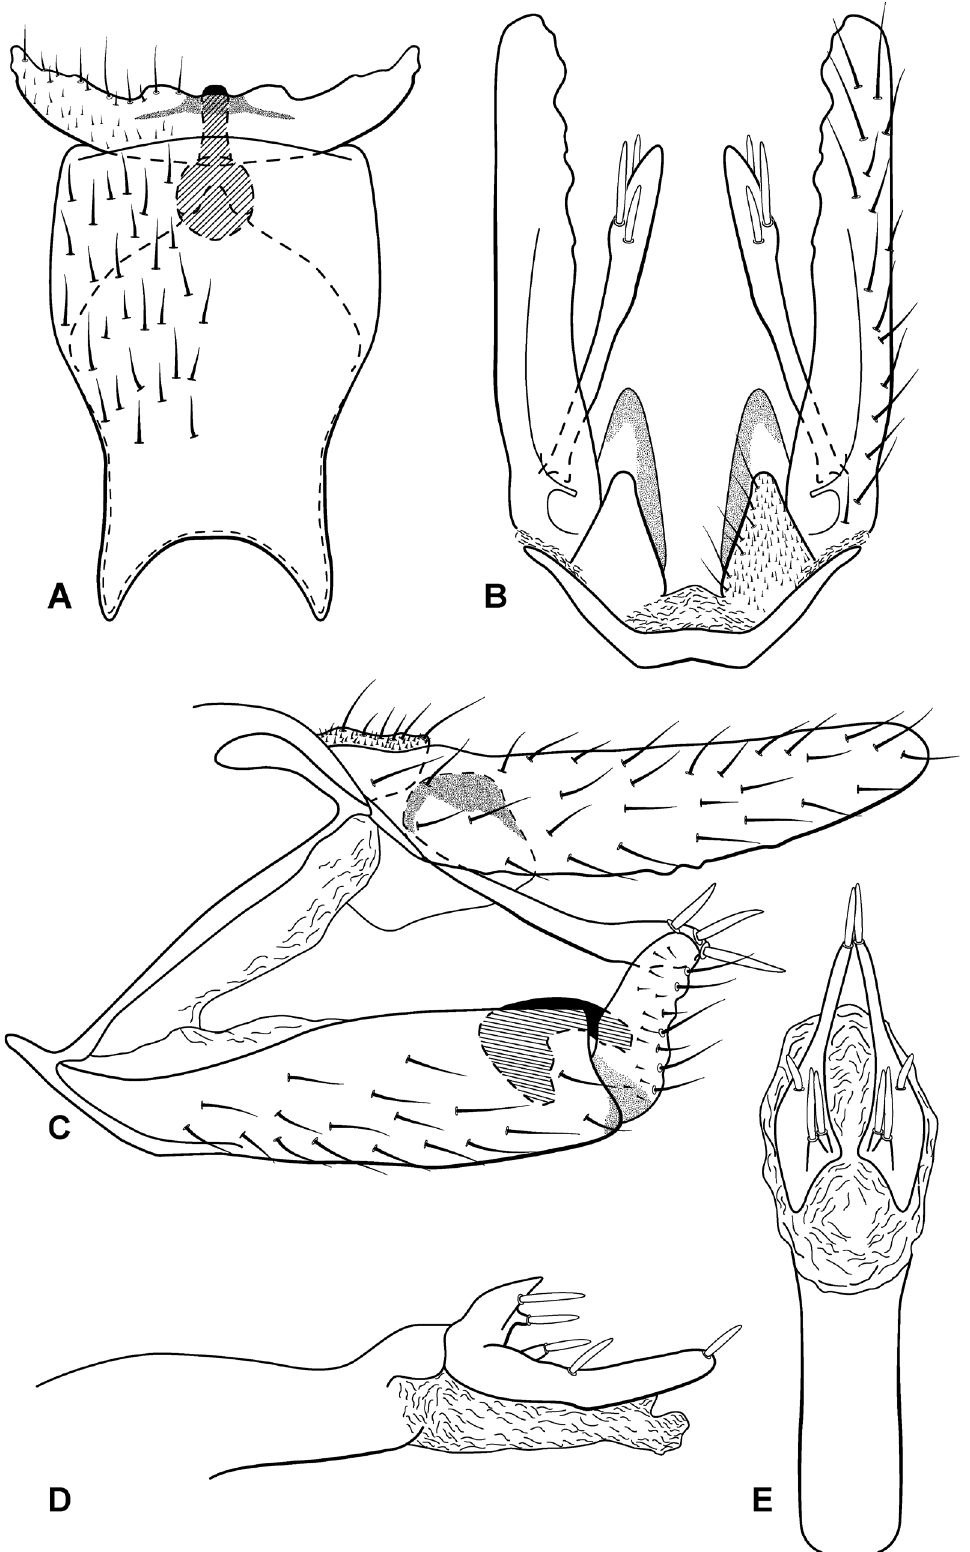
Fig. 4. Austrotinodes chagasi sp. nov., male genitalia. A . Ventral view. B . Dorsal view. C . Left lateral view. D . Phallic apparatus, left lateral view. E . Phallic apparatus, dorsal